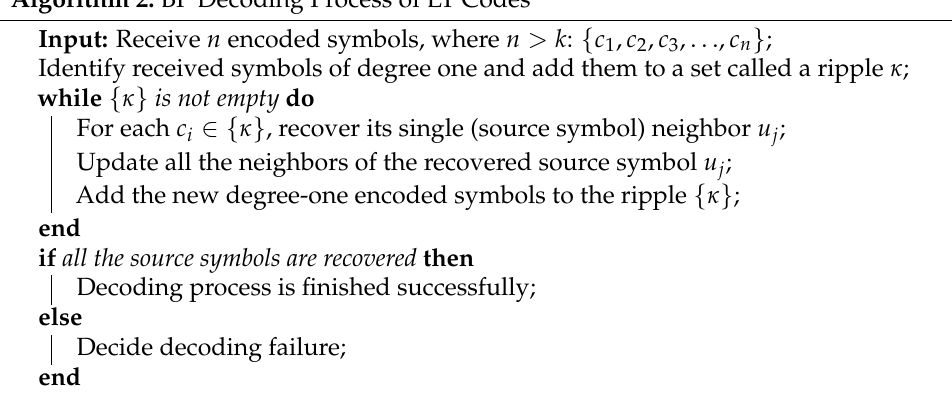
Algorithm 2: BP Decoding Process of LT Codes